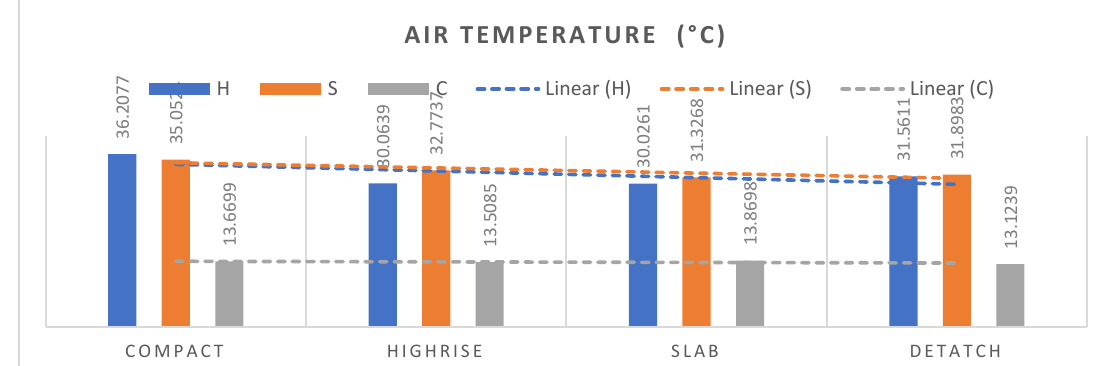
Fig. 14: Comparison of average air temperature from simulation performed on the hottest, coldest and sultriest days of the year between four selected morphotypes